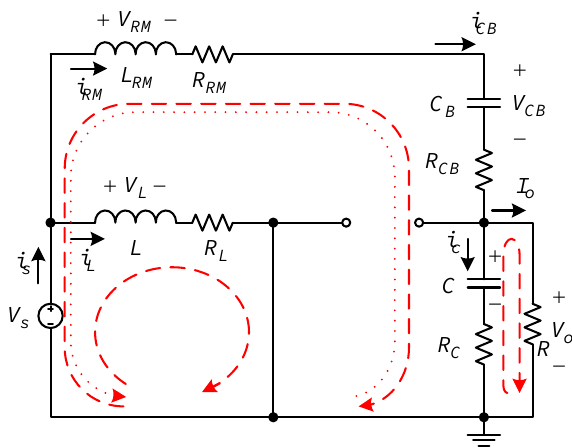
Figure 4. The equivalent circuit of the proposed converter in Mode